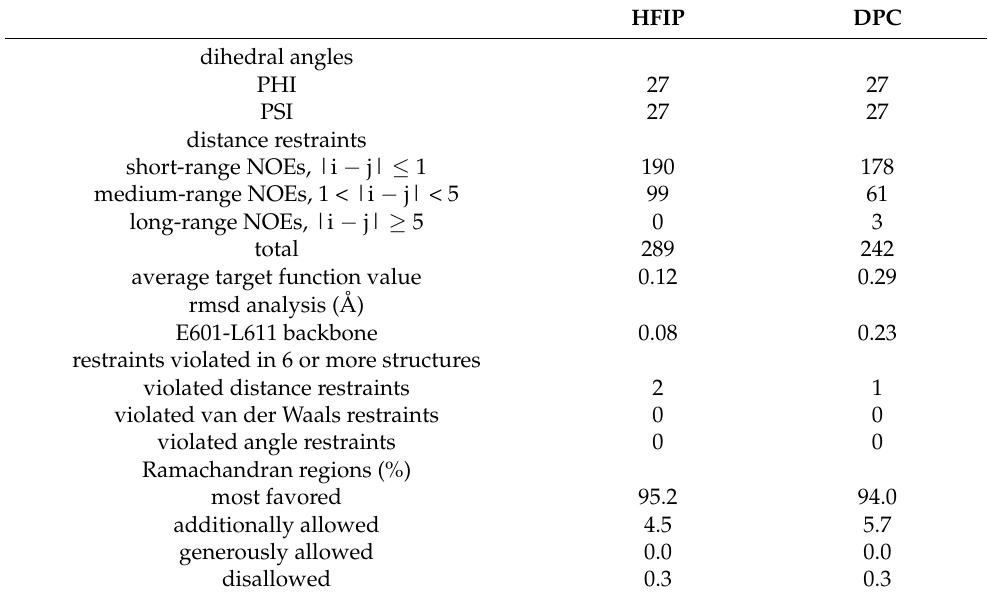
Table 3. NMR structural